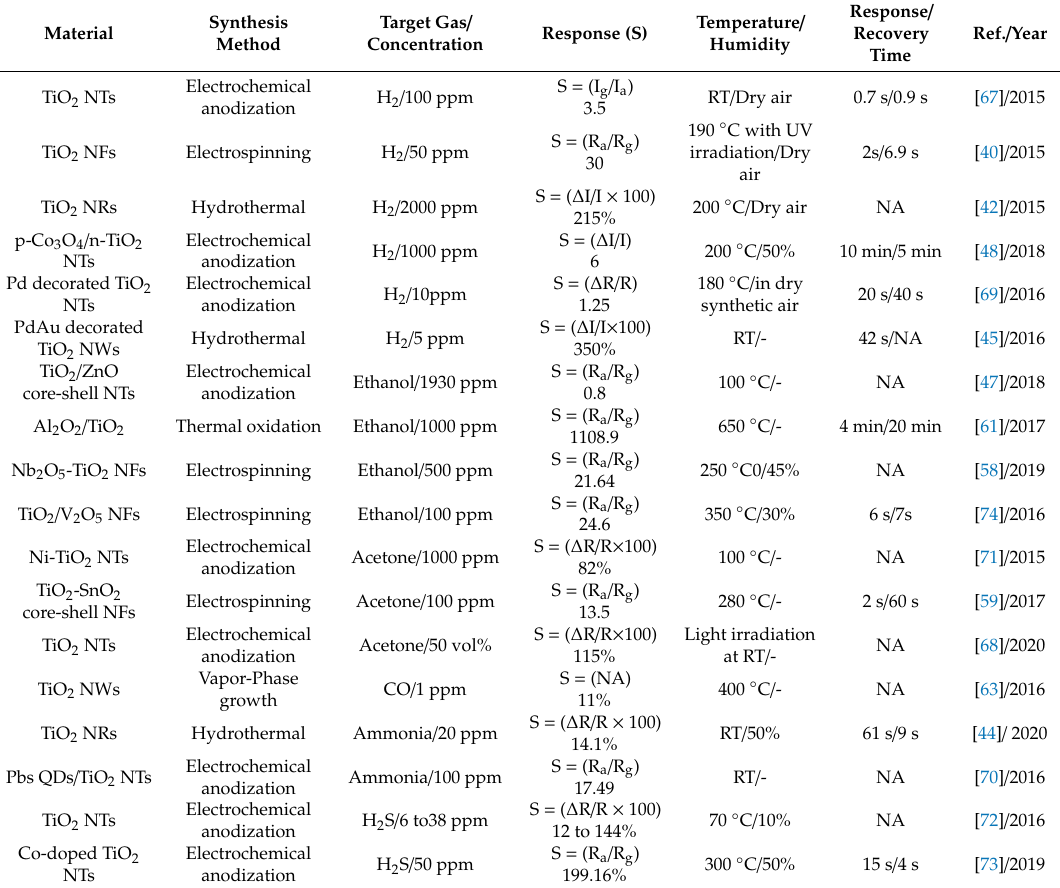
Summary of the chemical / gas sensing properties of TiO 2 -based nanostructures and heterostructures towards reducing